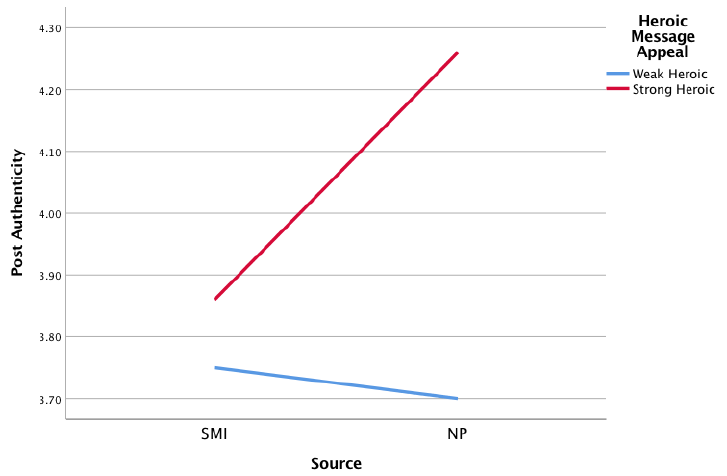
Table 4. Regression results (Source × Message Appeal on Post Authenticity).